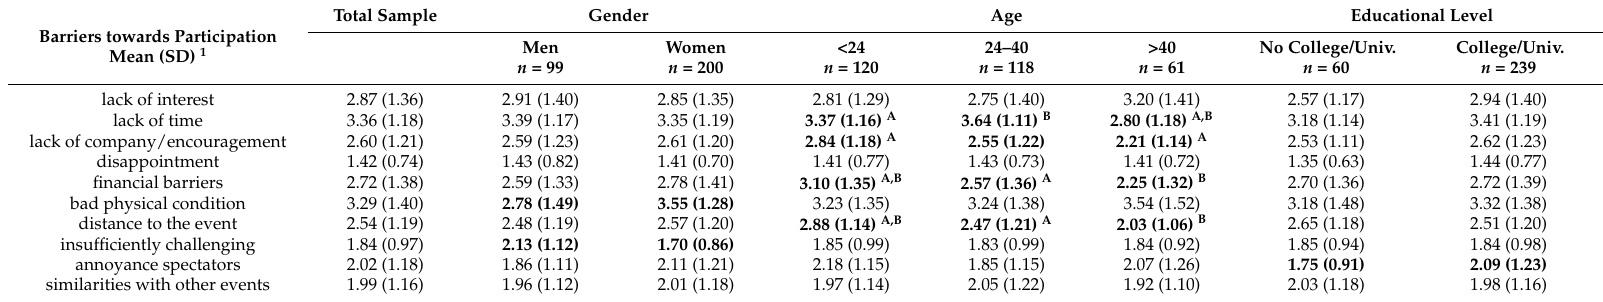
Table 4. Perceived barriers towards participation in a running event: descriptive statistics and differences between socio-demographic subgroups (gender, age, educational